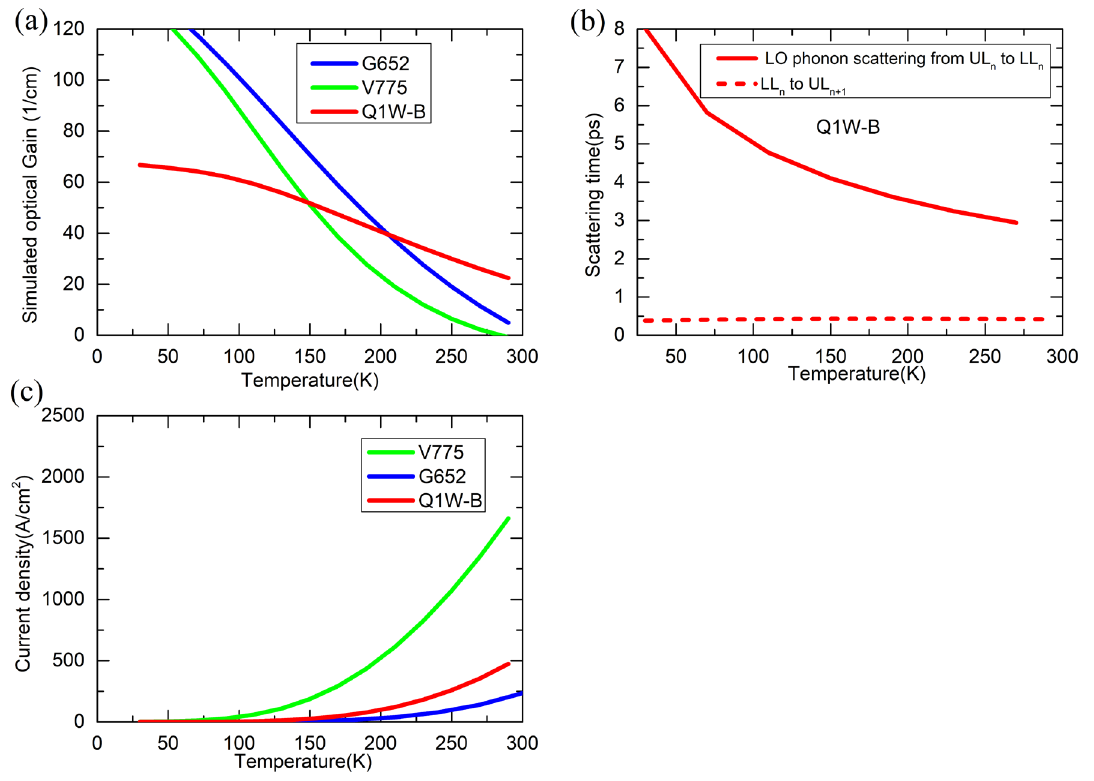
Figure 3. Temperature-dependent calculations via RE model. ( a ) Temperature-dependent optical gain, ( b ) LO phonon scattering time from UL n to LL n (solid line) and scattering time from LL n to UL n+1 (dashed line), and ( c ) over-barrier leakage current based on RE model. Blue curve is two-well DP structure G652, green curve is RP structure V775, and red curve is the Q1W-B.